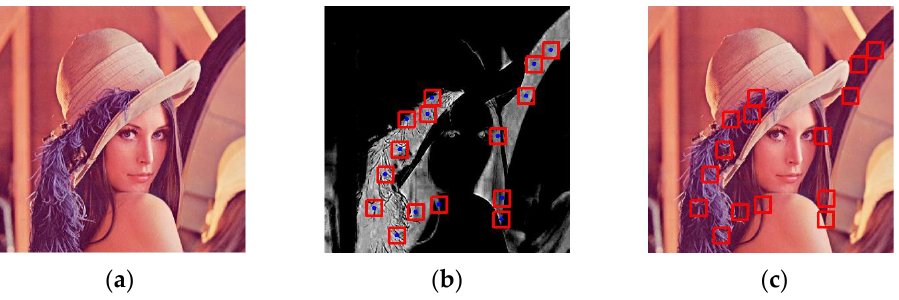
( c ) Figure 6. Applying a mask in sliding mode: ( a ) source image with the candidate patch positions marked with blue dots; ( b ) a binary mask with the patches that fit in the white (allowed) areas; ( c ) the resulting extracted patches. It should be noted that in sliding mode, the mask values are treated in a two-state fashion. That is, any non-zero value is considered 1, leading to a binary representation of the mask. In random mode, the mask ( M ) has a different interpretation. The mask is no longer binary but is considered a probability array denoting image areas that are favorable for patch extraction. Thus, the majority of the random patches is extracted from image loca- tions where the corresponding mask values are high. For instance, Figure 7 depicts the results of the command